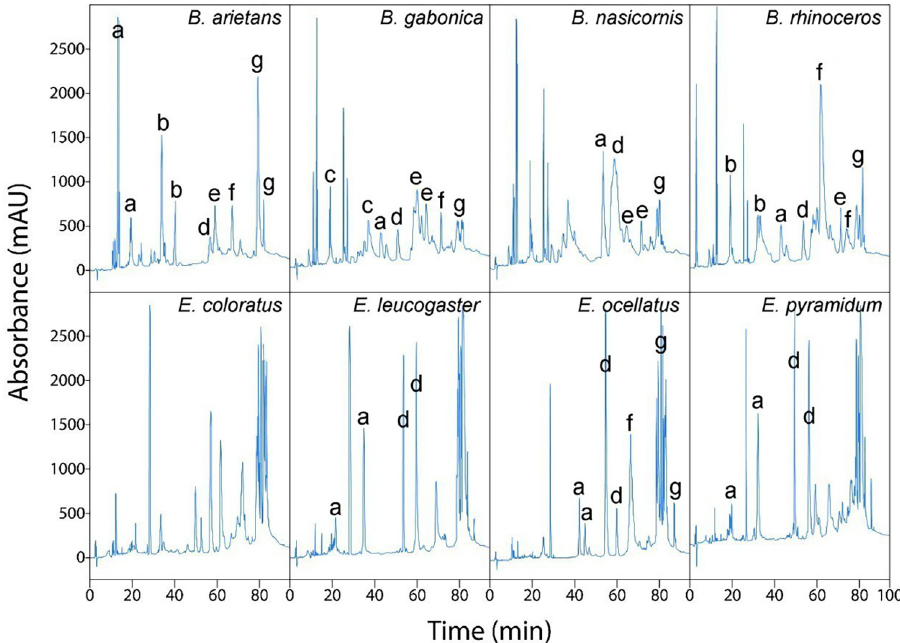
Fig 1. RP-HPLC chromatograms of venoms. Families of the most abundant toxins in the venom fractions were identified according to previously published proteomic analyses: a) disintegrins, b) Kunitz-type inhibitors, c) bradykinin potentiating peptides, d) PLA 2 s, e) SVSPs, f) C-type lectin-like proteins and g)